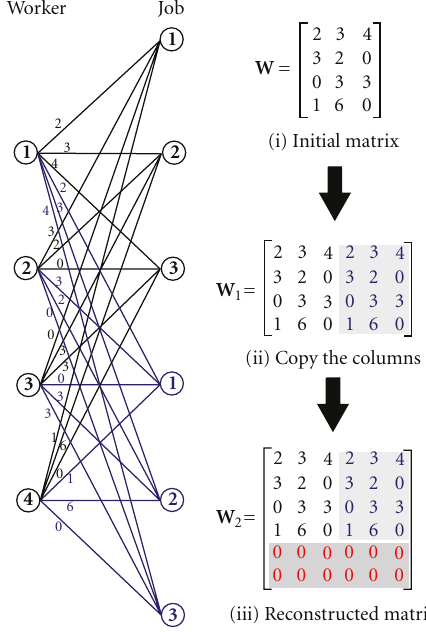
Figure 4: Asymmetric bipartite matching with resource realloca- tion ( n 1 > n 2